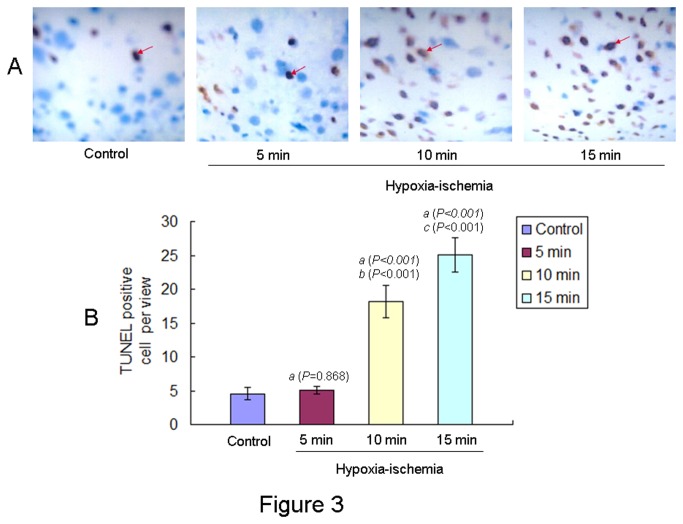
TUNEL staining of apoptotic cells in the brains of neonatal offspring rats from different groups.
A: Apoptotic cells were detected by TUNEL staining (dark brown, indicated by arrows) in the brains of offspring rats at PND 1 after ischemic injury. Scale bar: 400μm. 
B: Total TUNEL-positive cells were calculated in six randomly chosen views (three in hippocampus and three in cerebral cortex). Total TUNEL-positive cells per view from different groups (n=12 in each group) at PND 1 were showed. The results were expressed as mean ± S.D.. a: compared with the control group; b: compared with the 5 min HIE group; c: compared with the 10 min HIE group. The P values were showed in the bracket.